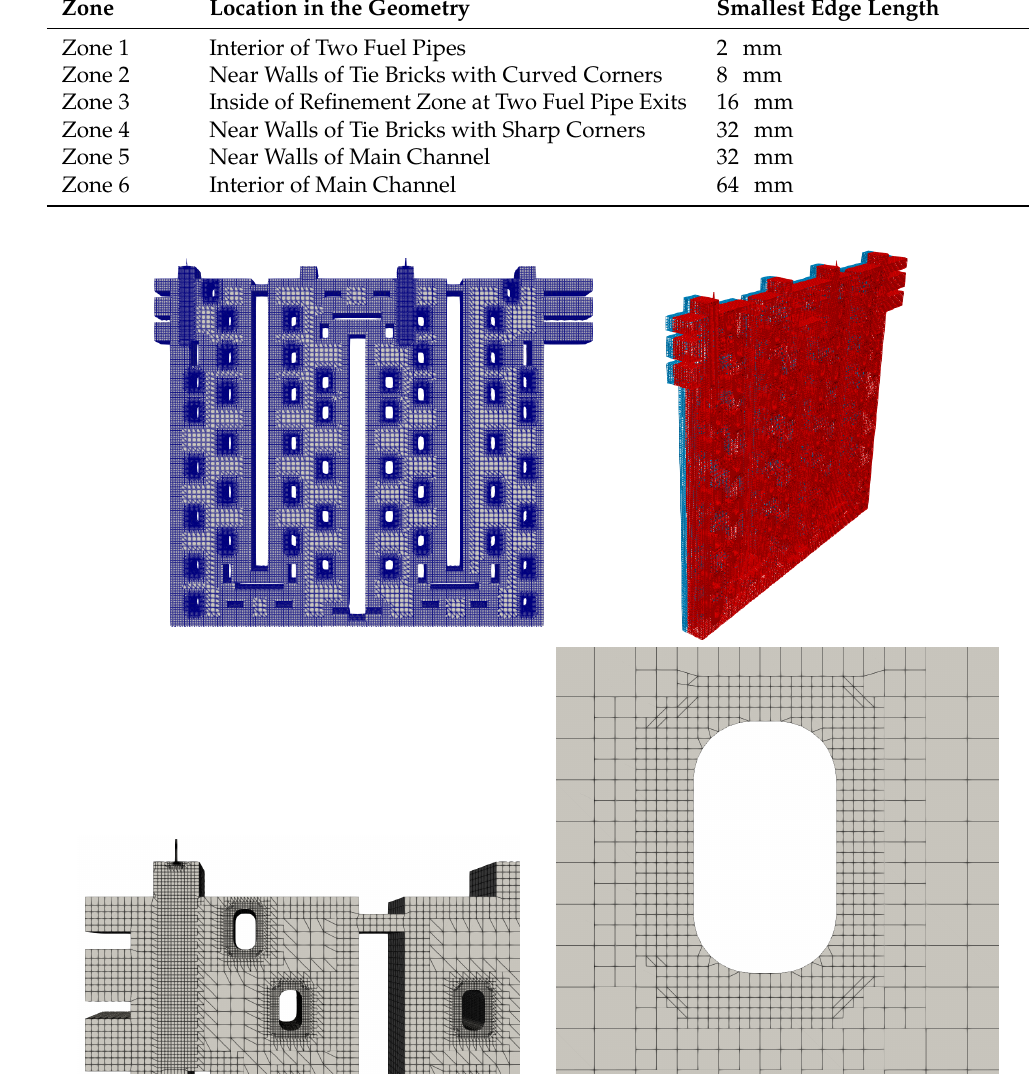
Figure 3. Three-dimensional mesh of approximately 670 k cells used in simulations. The ( top-left ) picture shows the front view on the gas domain. The ( top-right ) picture shows a three-dimensional view on the lining and flue domain ( top right the lining at the back and the flue in front. The ( bottom-left ) picture shows a details near the air inlet with local refinement underneath the first burner outlet, refinement around the tie-bricks and the top by-pass. The ( bottom-right ) picture shows the refinement around a representative